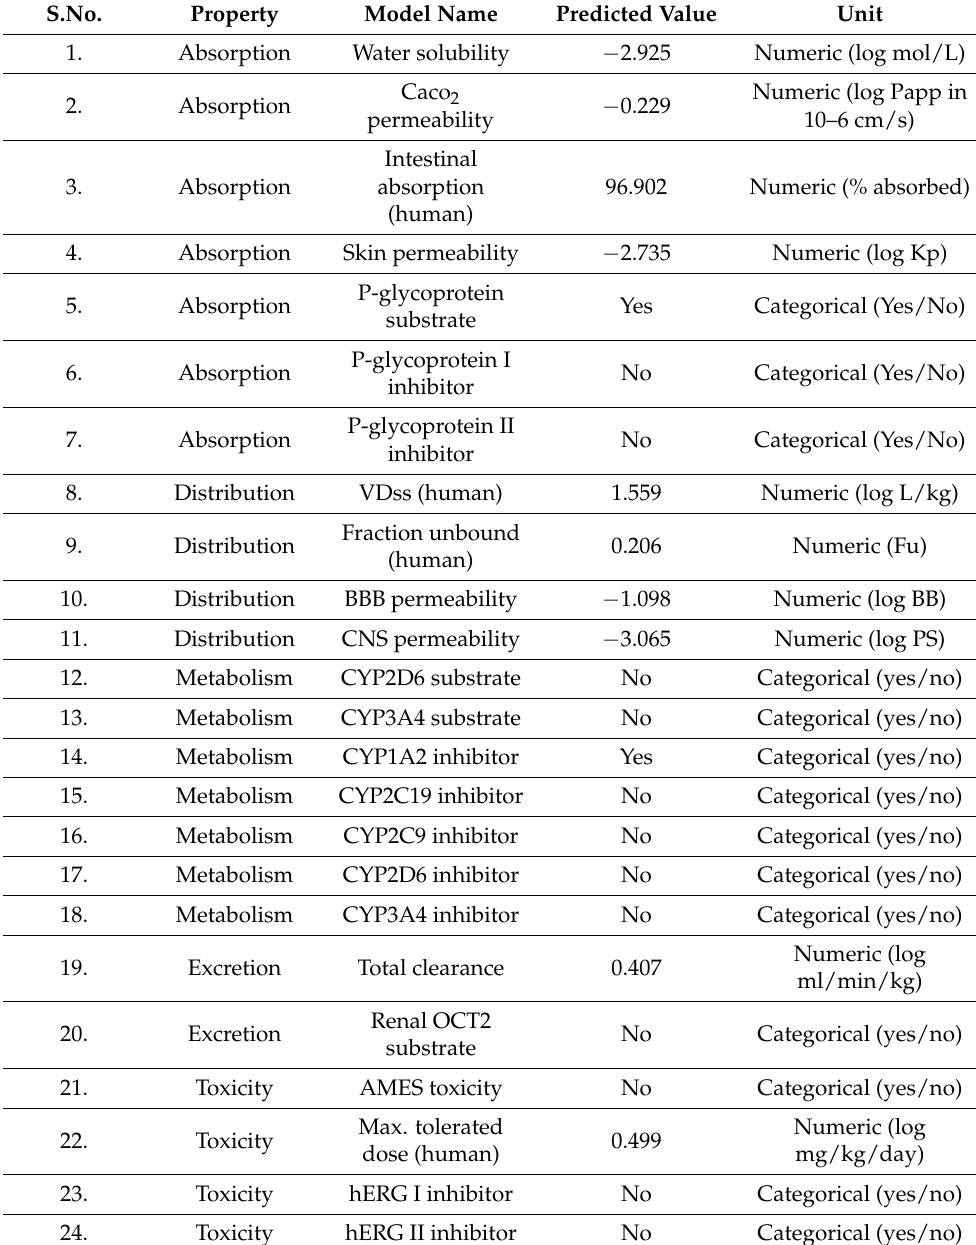
Table 8. Pharmacokinetic properties of